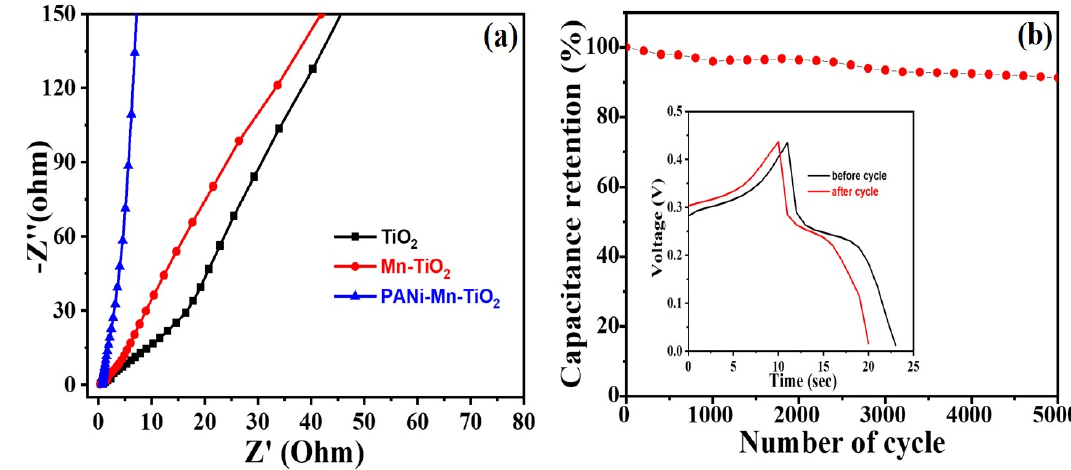
Figure 5. EIS and stability test, ( a ) Nyquist plots of TiO 2 , Mn-TiO 2 and PANi/Mn-TiO 2 , and ( b ) cycling stability of PANi/Mn-TiO 2 . (Inset ( b ) shows GCD profile before and after cyclic stability